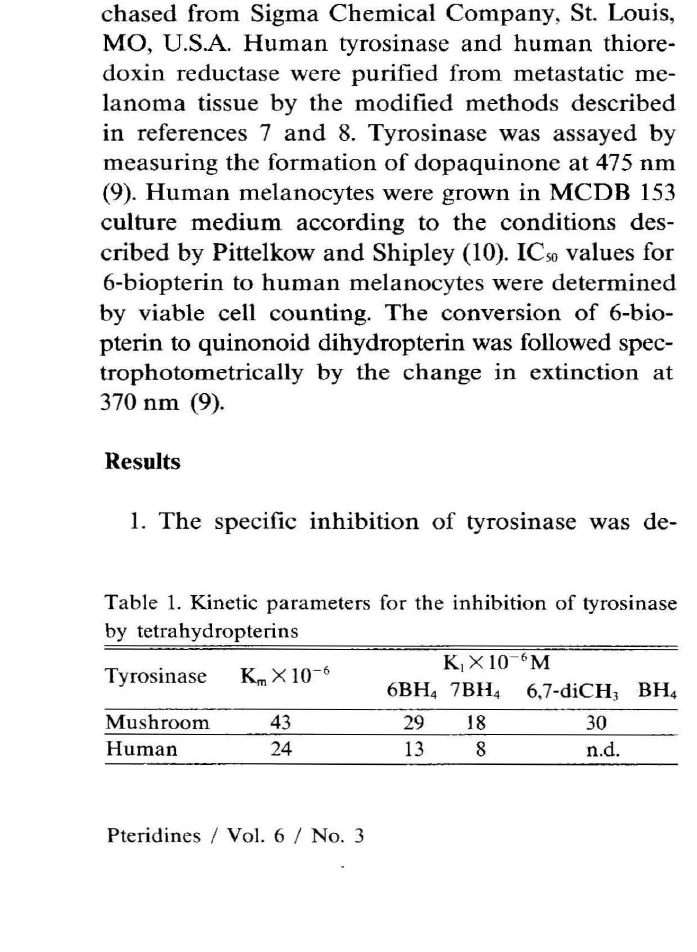
Table 1. Kinetic parameters for the inhibition of tyrosinase by tetrahydropterins